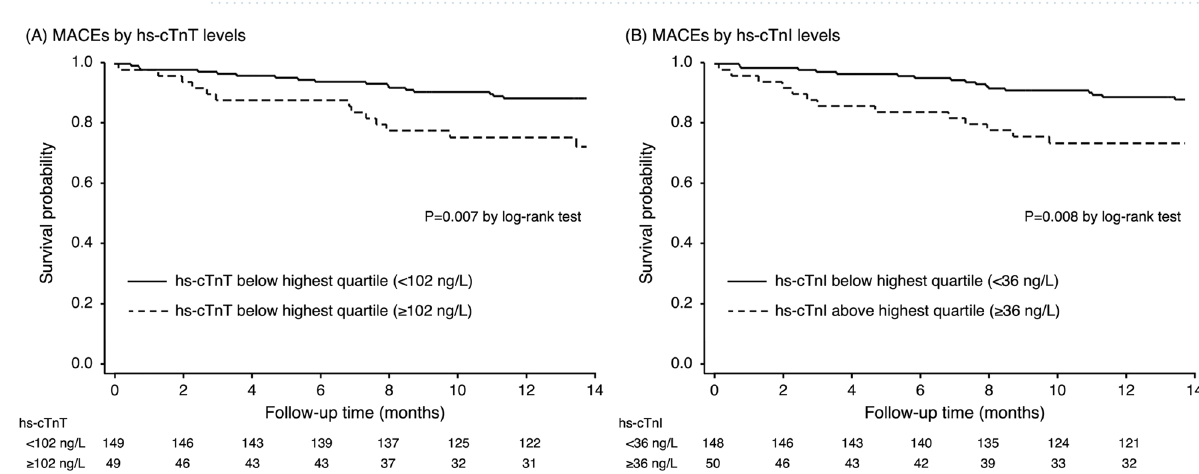
Figure 2. Kaplan–Meier survival curve analysis for MACEs in patients above or below the highest quartile of hs-cTnT ( A ) and hs-cTnI ( B